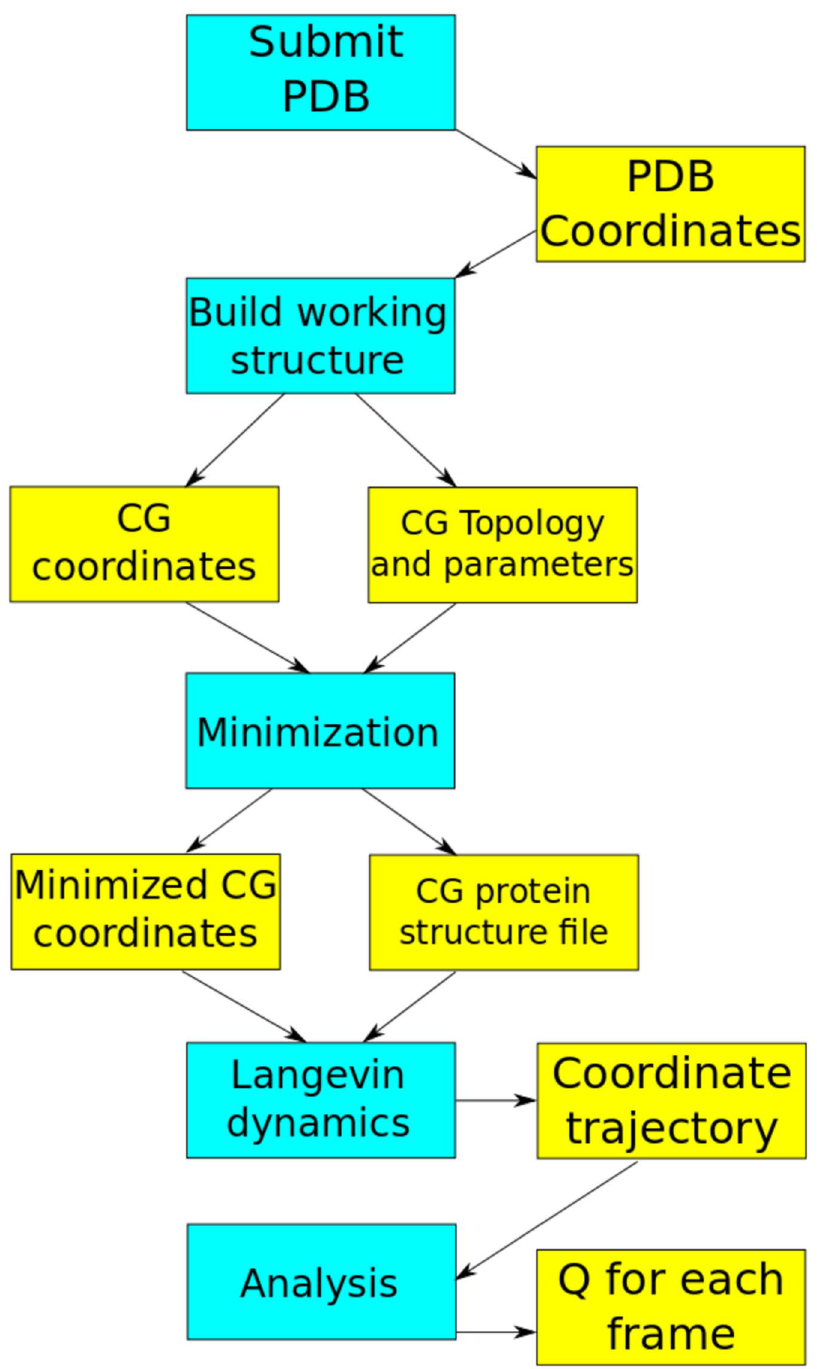
Figure 4. The workflow of the KT G (cid:2) oo model lesson. Blue boxes represent the steps described in the text. Yellow boxes show the inputs and outputs of each step. Note that the CHARMM protein structure file is only built when a calculation is performed (minimization, in this case). Q is the fraction of native contacts as defined in the